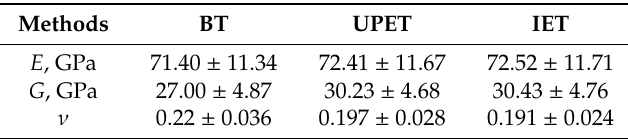
Table 4. Test results of E , G and ν .